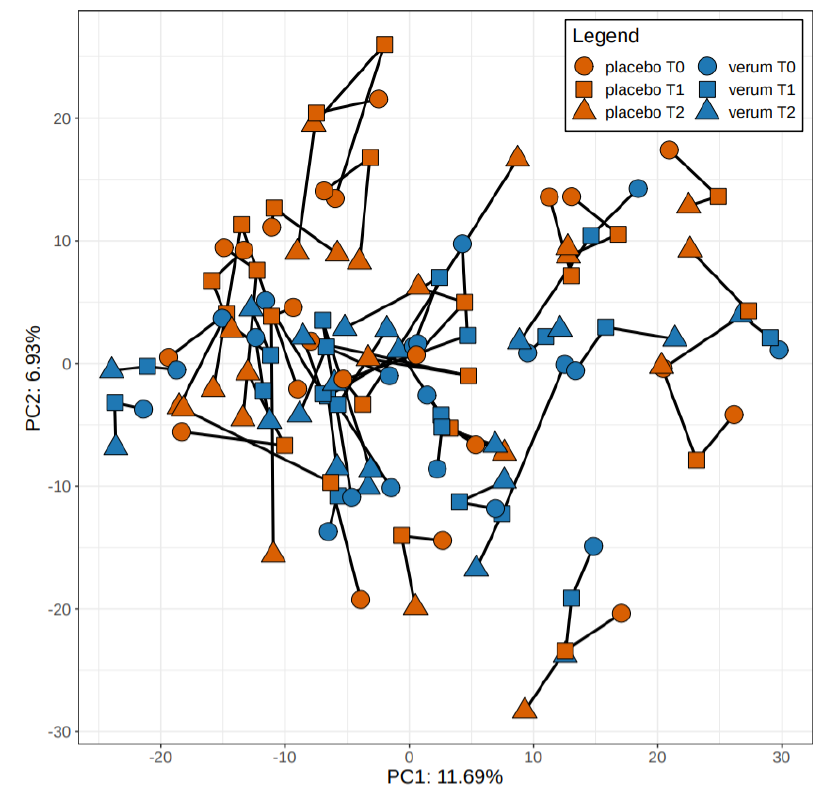
Figure 3. Principal component analysis of participants of verum and placebo group at all three time points.